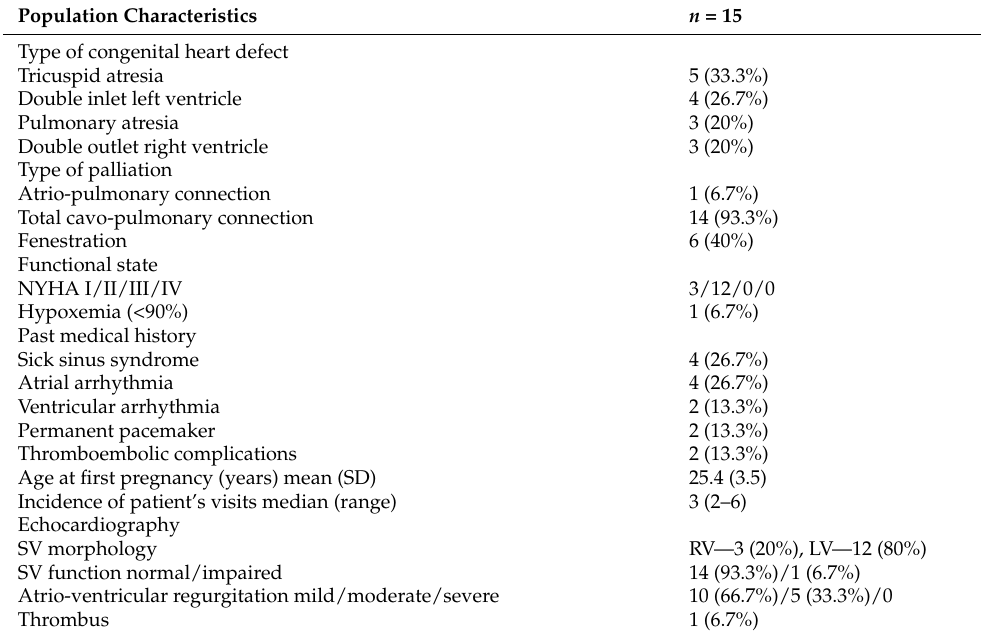
Table 1. Pre-conception baseline maternal